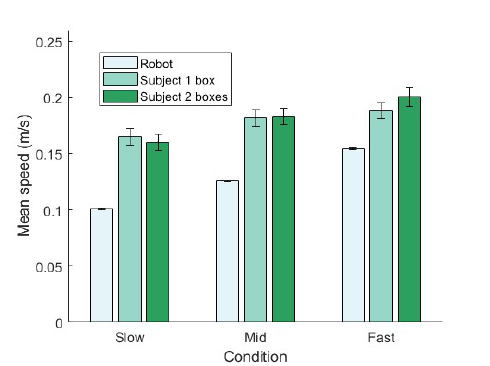
Figure 4: Mean speed, and standard error (error bars) of the robot and subjects for all conditions in